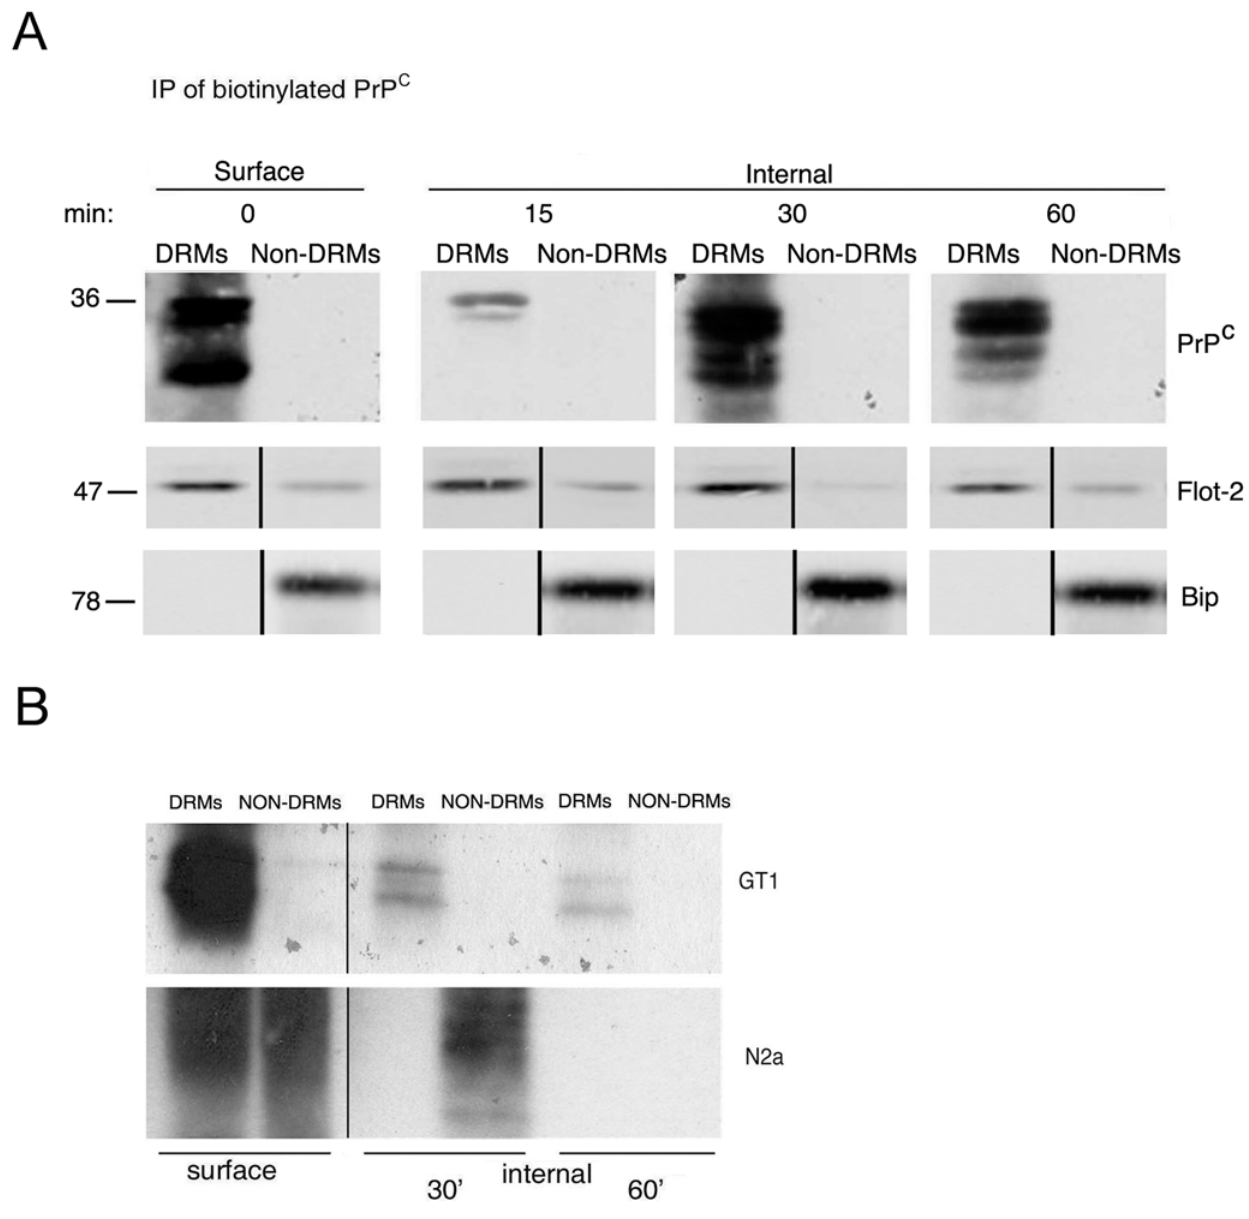
Figure 5. Internalization of PrP C occurs in DRMs. A) FRT-PrP C cells grown for 4 days on filters and incubated with disulfide-linked biotin at 4 u C, were either solubilized immediately (surface) or first incubated for 15, 30 and 60 min at 37 u C to allow internalization and then subjected to biotin stripping by a reductive cleavage and then solubilized (internal). The cell lysates were subjected to a ‘‘Two Step’’ OptiPrep TM density gradient to separate DRM (fractions 4–5) from non-DRM fractions (6–12). Fraction 5 and 11 were immunoprecipitated with a PrP SAF32 antibody and biotinylated PrP C was revealed with streptavidin-HRP. To test the efficiency of fractionation, before PrP C immunoprecipitation, an aliquot of fraction 5 and 11 was immunoblotted for Flotillin-2 (Flot-2 as raft marker, [82]) and Bip/Grp78 (as non-raft marker, [80]). B) GT-1 and N2a cells grown for 4 days on dishes were incubated with disulfide-linked biotin at 4 u C and were either solubilized immediately (surface) or first incubated for 30 and 60 min at 37 u C to allow internalization. They were then subjected to biotin stripping by a reductive cleavage and solubilized (internal). The cells were subjected to a ‘‘Two Step’’ OptiPrep TM density gradient to separate DRM (fractions 4–5) from non-DRM fractions (6–12). Fraction 5 (DRMs) and 11 (non- DRMs) were immunoprecipitated with a PrP SAF32 antibody and revealed with